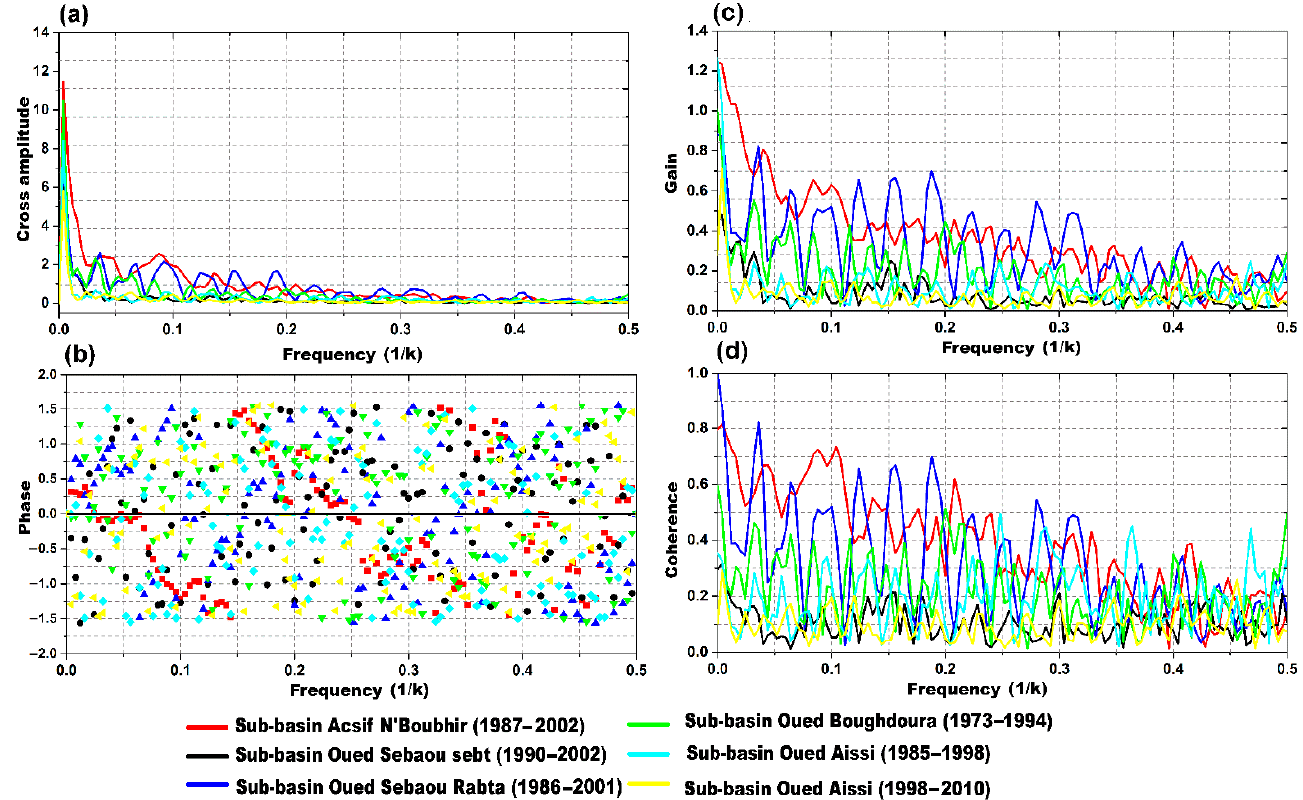
Figure 8. ( a ) Cross amplitude function, ( b ) phase function, ( c ) gain function, and ( d ) coherence function of the rainfall-runoff relationship of the main sub-basin of the Sebaou River basin (windows of 125 days).